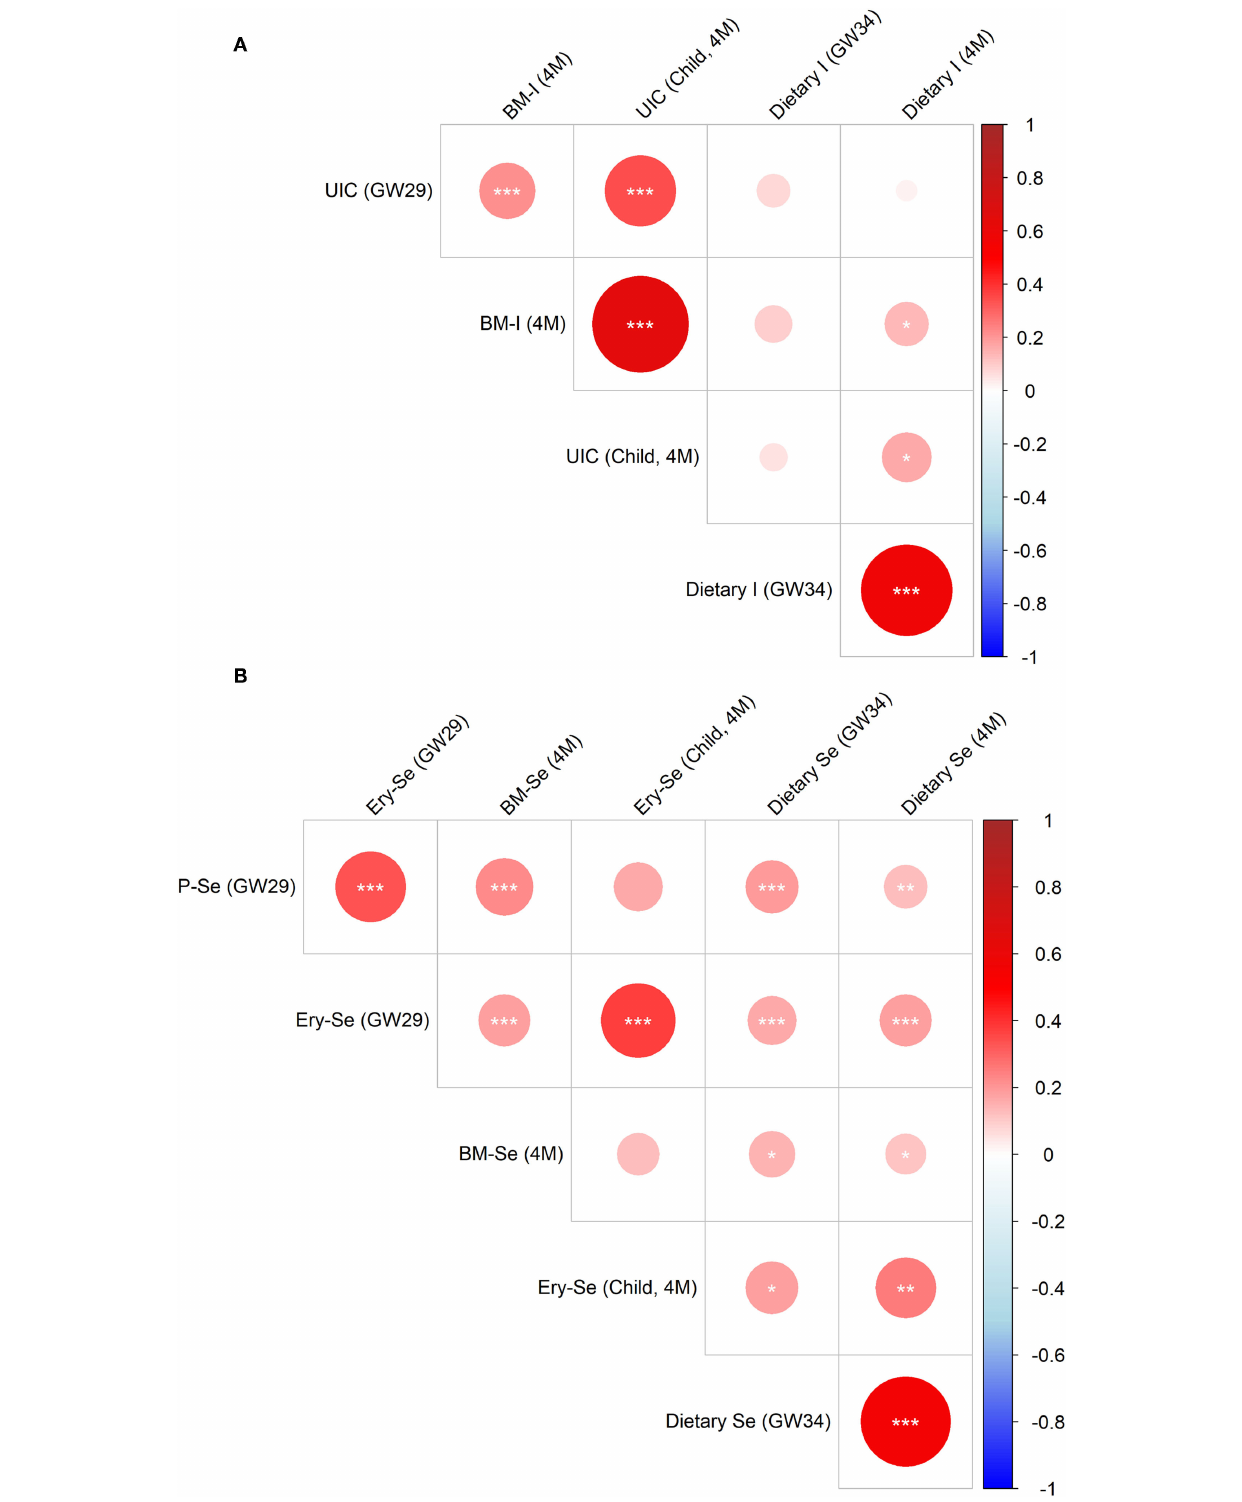
Frontiers in Nutrition |